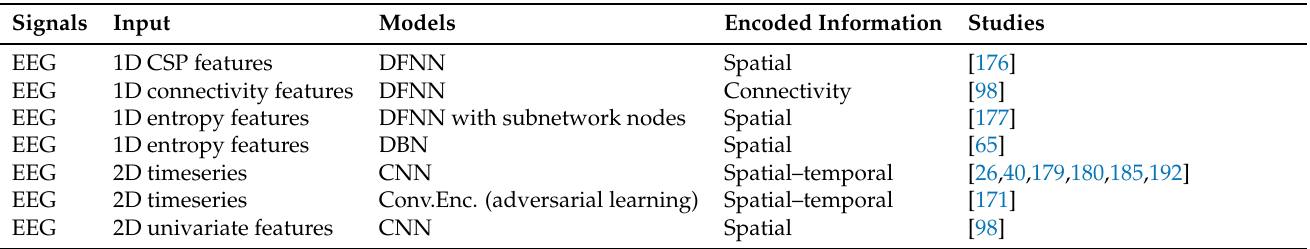
Table 6. Summary of deep learning-based representation learning and recognition in cognitive